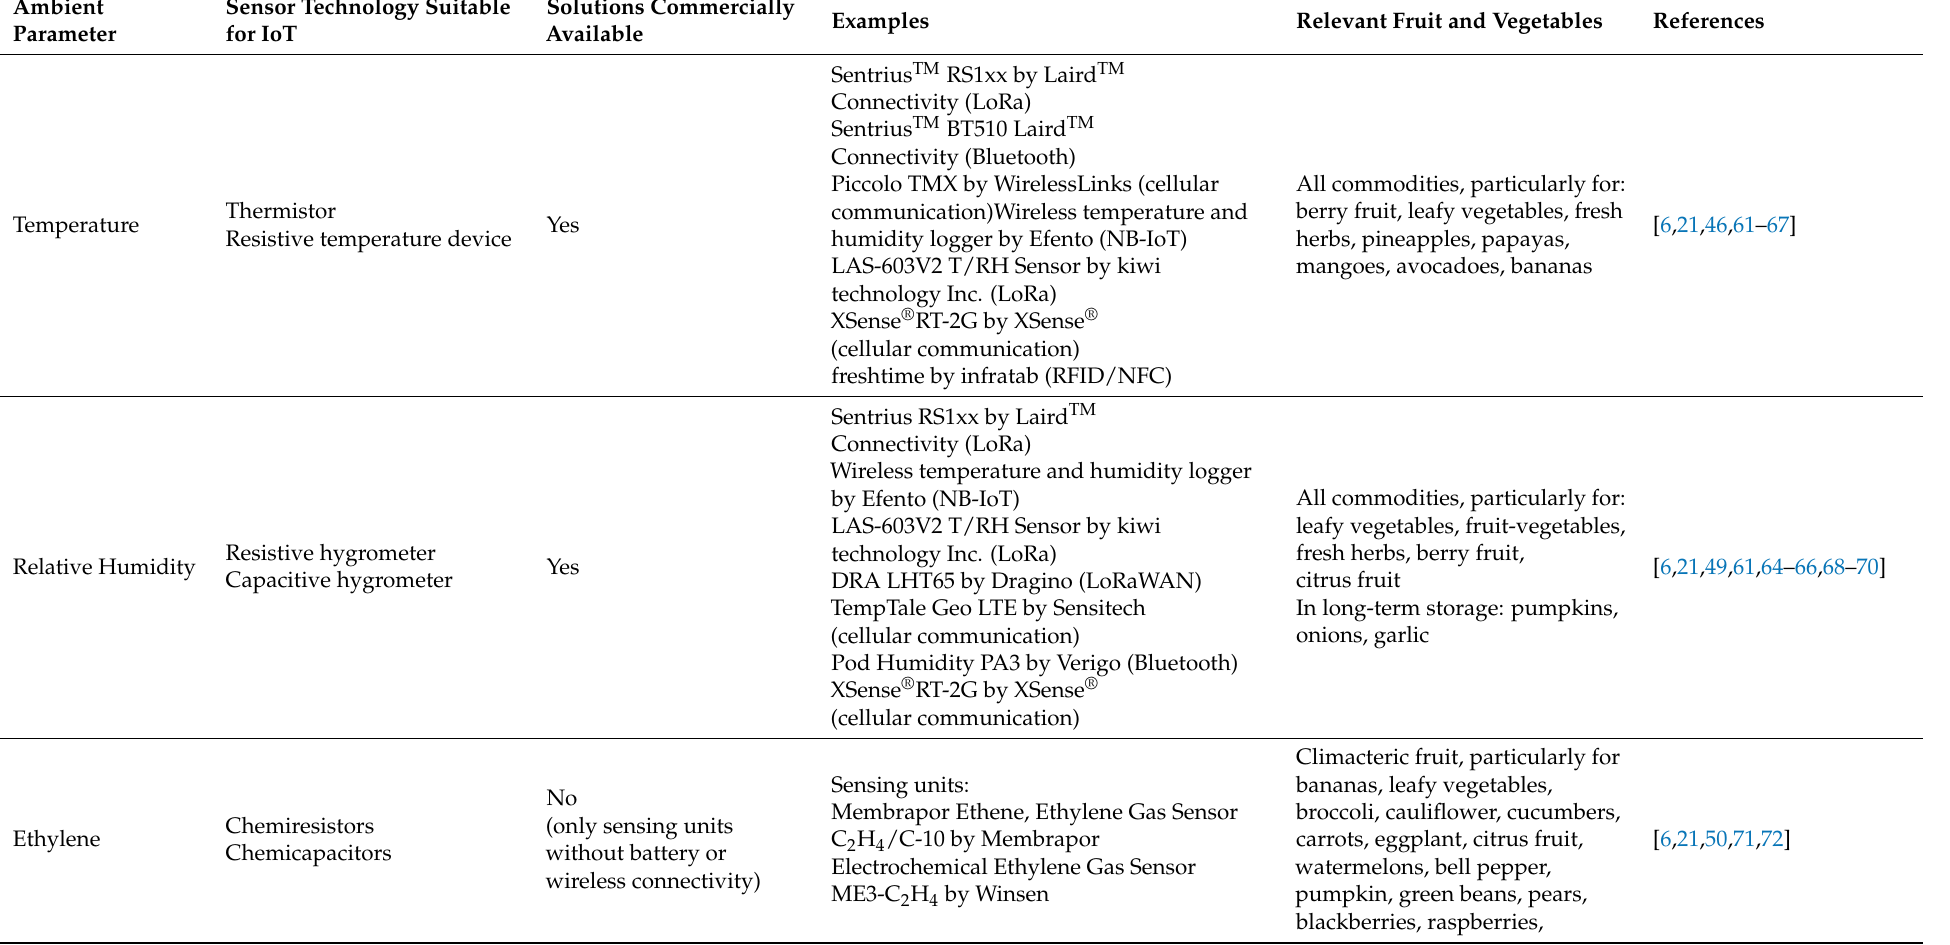
Table 1. Overview of ambient parameters and corresponding sensor technology for an IoT